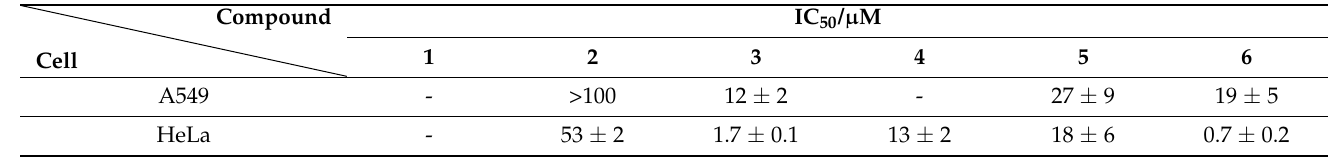
Table 4. Tumor cell growth inhibition presented as IC 50 values (in µ M) evaluated from the MTT test after 72-h incubation.